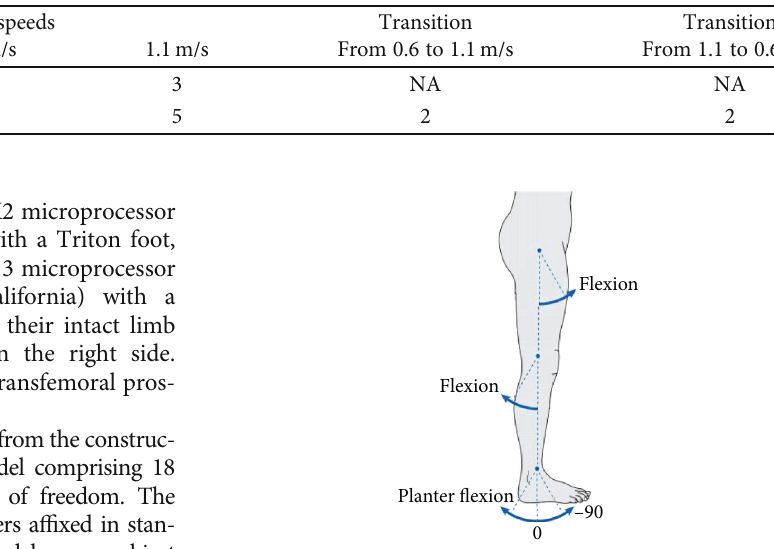
Table 6: The number of trials is listed for each walking speed for the prosthesis users.